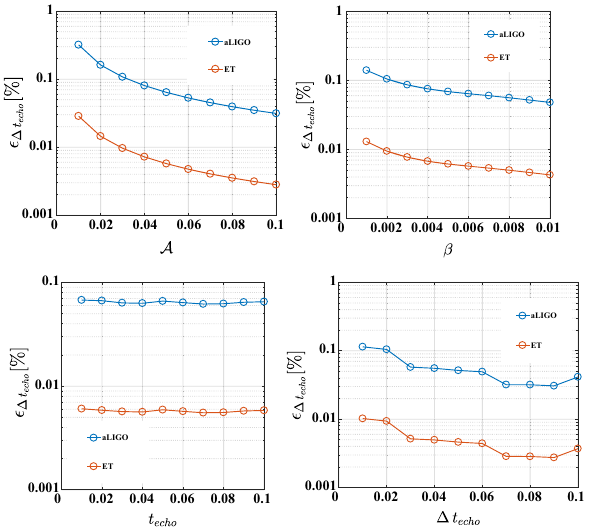
Fig. 4 Relative error on (cid:3) t echo for CIE templates, computed with forecast Advanced LIGO at final design sensitivity (blue) and ET with the forecast sensitivity (red)